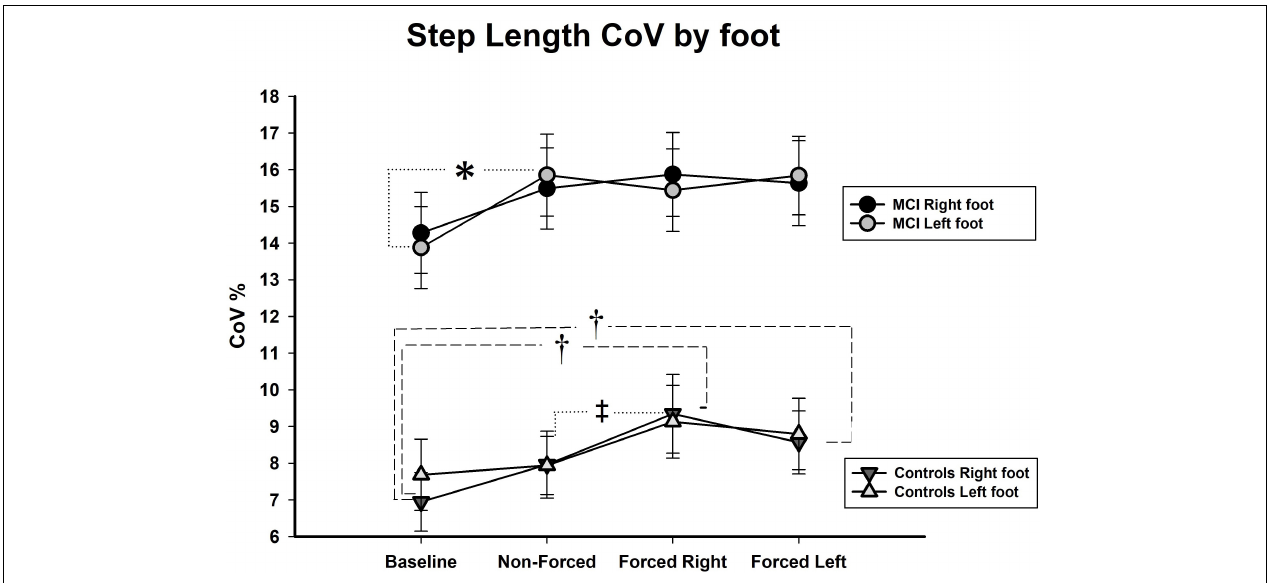
FIGURE 4 | CoV, coefficient of variance, shown in %; aMCI, amnestic mild cognitive impairment; R, right; L, left; (significance level in aMCI shown with ∗ p < 0.05; ∗∗ p < 0.01; and ∗∗∗ p < 0.001. Significance in healthy controls shown as † p < 0.05 for one limb and ‡ p < 0.05 for both limbs).